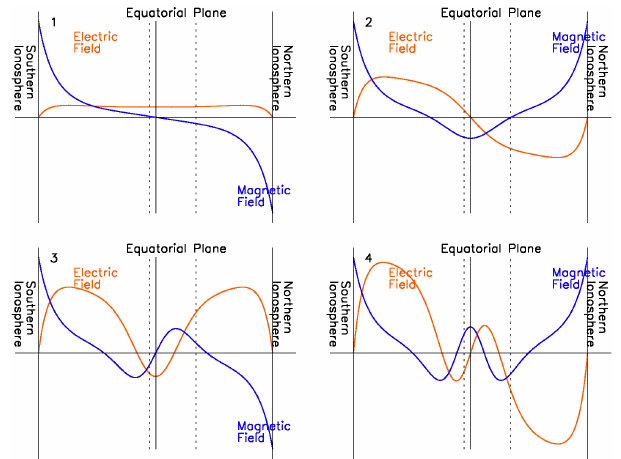
Fig. 12. Numerical solution of the wave equation on a dipolar field line. The first four harmonics are shown. Superimposed are the scaled positions of the Cluster 3 (right of the equatorial plane) and 4 (left) spacecraft.